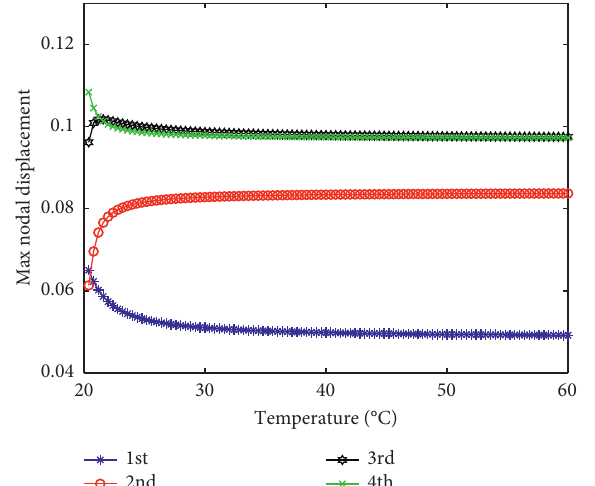
Figure 5: The change curves of max nodal displacement of each vertical modal shape under different environmental